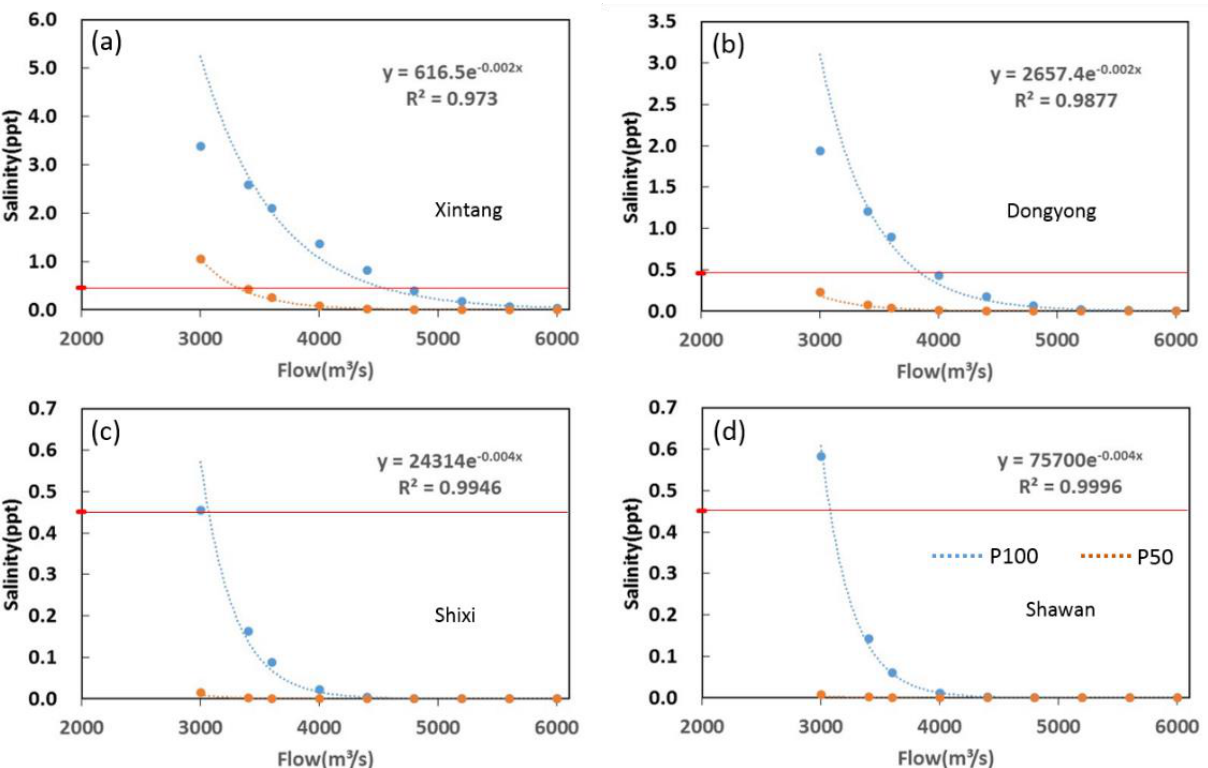
Figure 7. Exponential relationship between the river flow and salinity at Xingtang ( a ), Dongyong ( b ), Shixi ( c ), and Shawan ( d ). The results are obtained under the 50- and 100-cm sea-level-rise scenarios, respectively. The threshold rates of river flow are set to 3000, 3400, 3600, 4000, 4400, 4800, 5200, 5600, and 6000 m 3 /s, respectively.